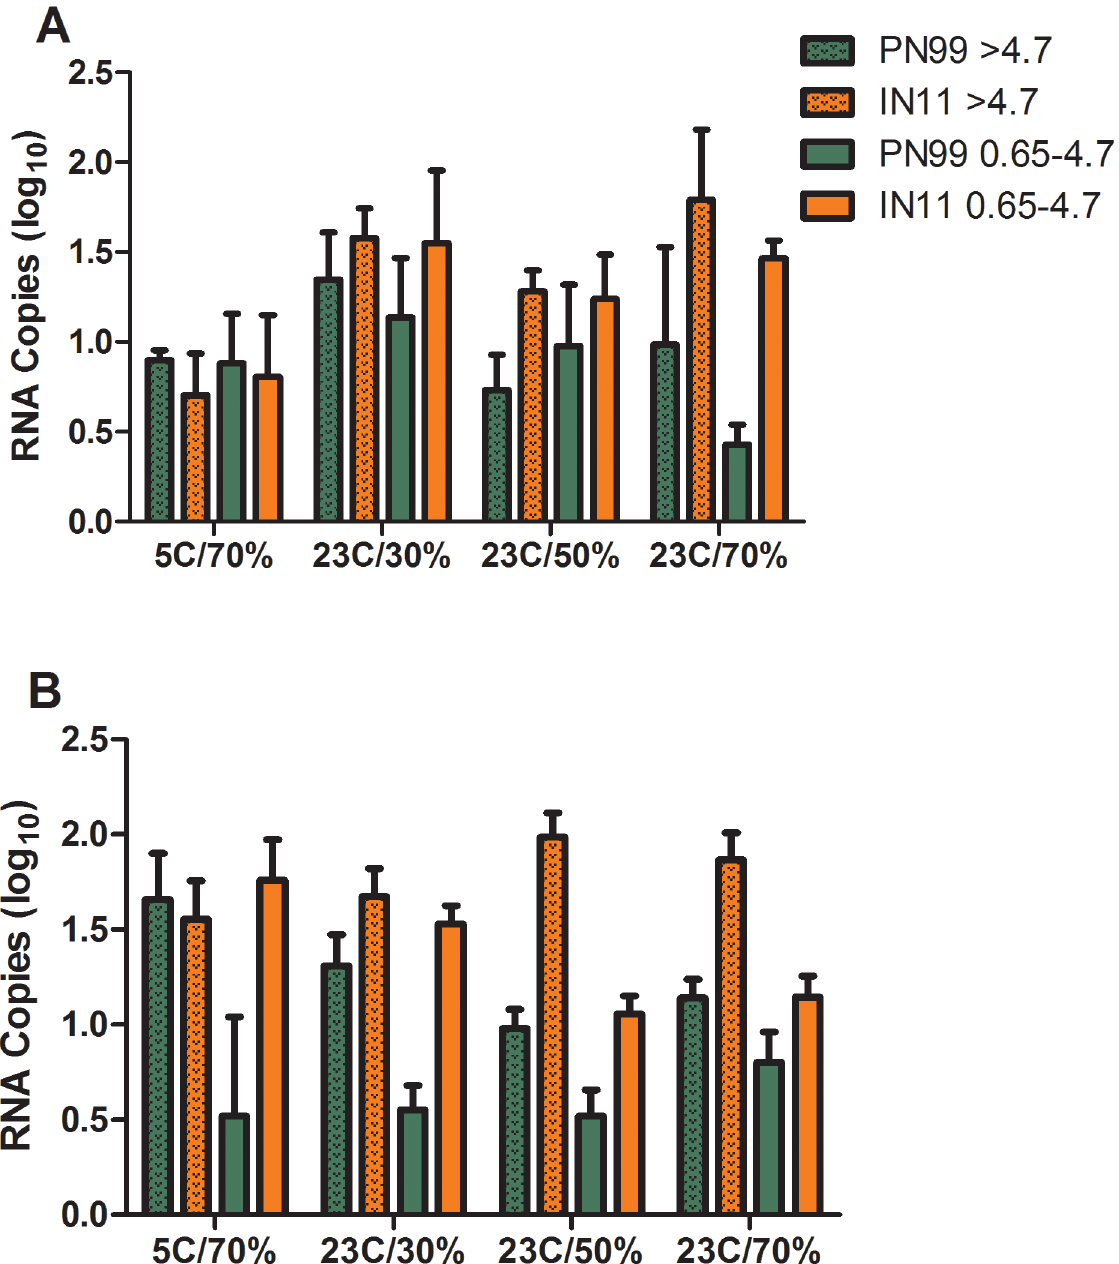
Fig 6. Influenza virus RNA detection in aerosol samples exhaled by infected ferrets. Three ferrets each were housed under the designated environmental conditions and were presented with 10 3.8 – 10 5.5 pfu of PN99 (green) or IN11 (orange) virus by aerosol inhalation. On 1, 3 and 5 dpi, aerosol samples were collected from ferrets for 15 minutes of normal breathing (A) and 5 minutes of sneezing stimulation (B) and were segregated based on size (0.65 – 4.7 μ m or > 4.7 μ m) and then assayed for the presence of influenza virus RNA copies. RNA copy data from the three time points are combined and presented +SEM for each